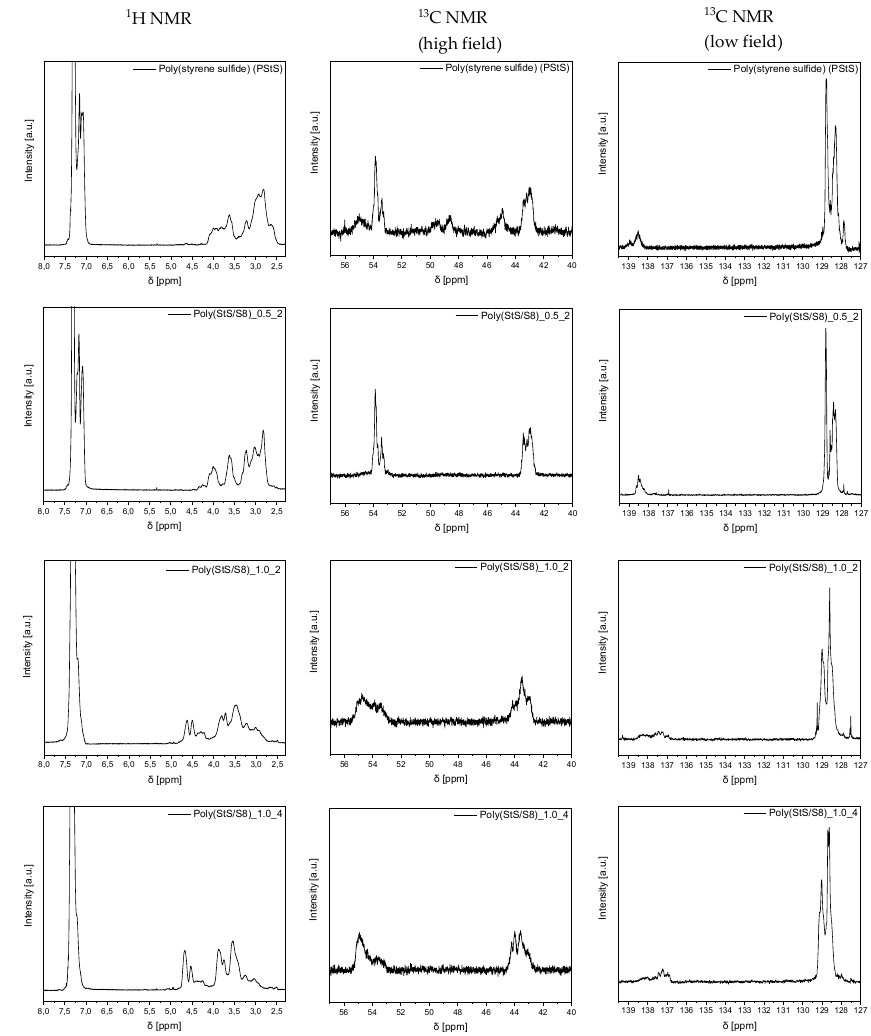
Figure 10. The 1 H NMR and 13 C NMR spectra of poly (StS) and poly (StS/S 8 ) copolymers.